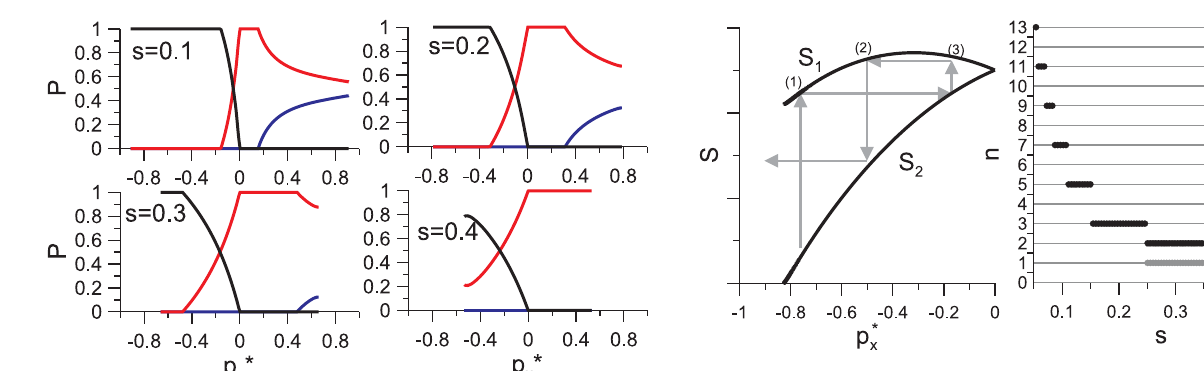
Fig. C1. Left panel demonstrates the scheme of the calculation of the number of uncertainty curve crossings. Right panel demon- strates the number of uncertainty curve crossings at p ∗ x < 0 for tra- jectories of the first type (black) and the second type (grey) as func- tions of s